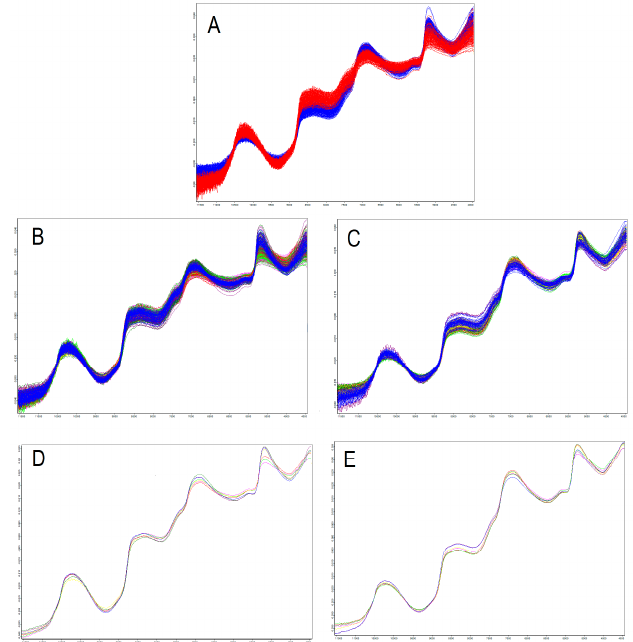
Figure 1. ( A ) Superimposed normalized Fourier-transform near infrared spectroscopy (FT-NIR) spectra (absorbance vs. wave numbers) of single berries for “Autumn Royal” (blue) and “Victoria” (red). Normalized spectra with maturity level-based coloration: “Autumn Royal” ( B ) and “Victoria” ( C ). Averaged spectra for each maturity level: “Autumn Royal” ( D ) and “Victoria” ( E ).